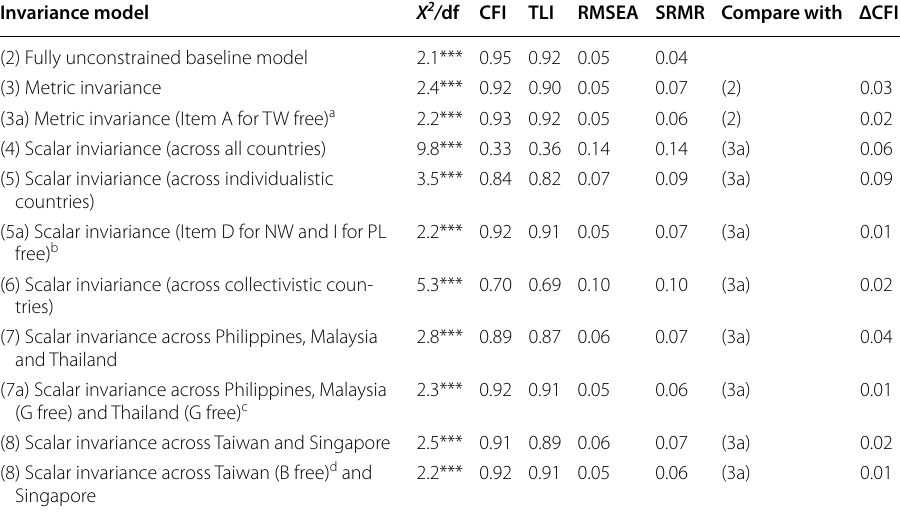
Table 3 Goodness of fit indices for measurement invariance between